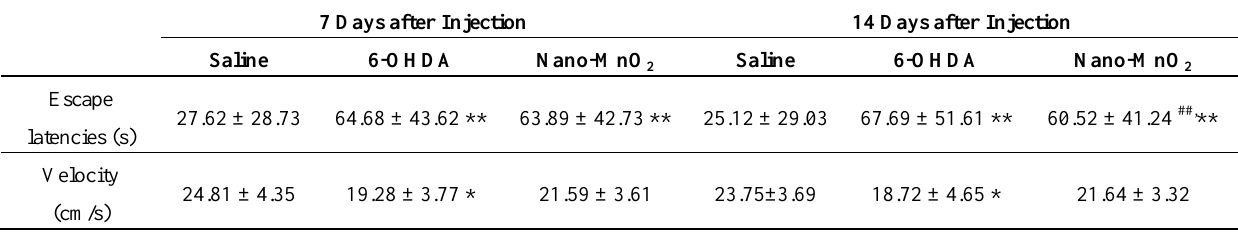
Table 1. Escape latency and score of rats in Morris water maze test ( ± s). 7 Days after Injection 14 Days after Injection Saline 6-OHDA Nano-MnO 2 Saline 6-OHDA Nano-MnO 2